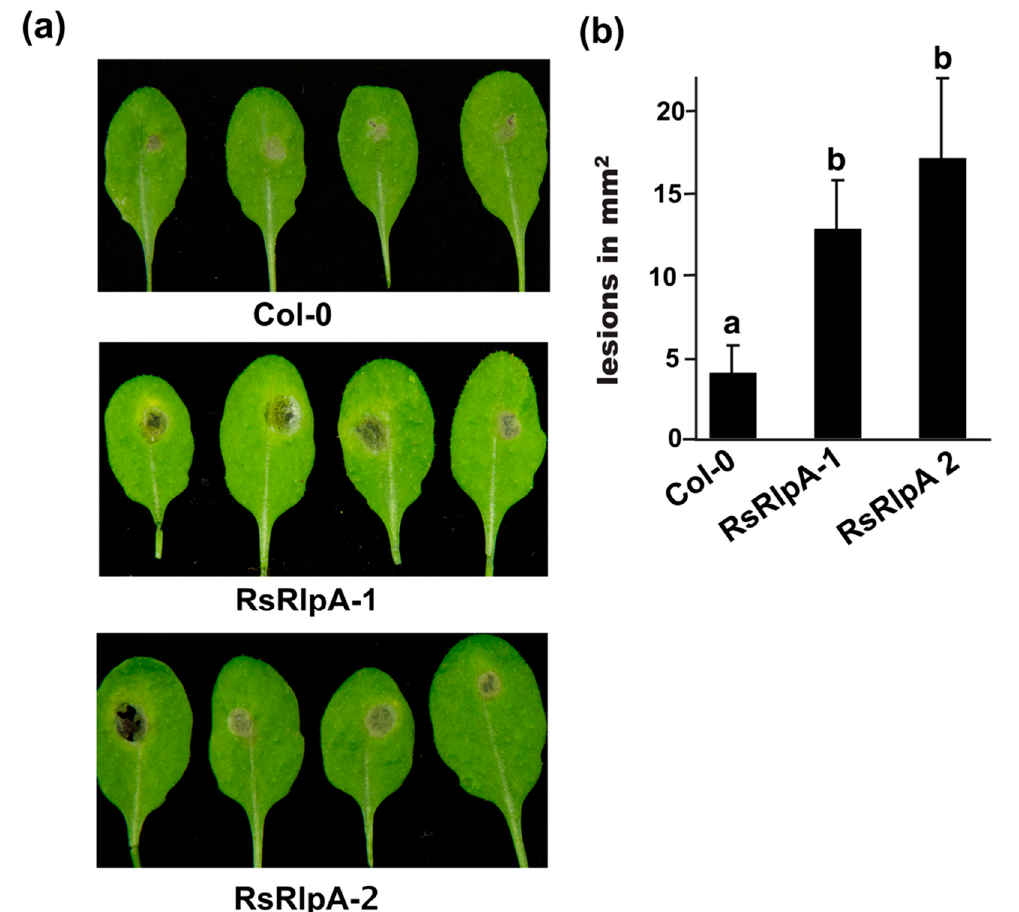
Figure 2. Expression of RsRlpA in Arabidopsis thaliana promotes fungal infection. ( a ) Symptoms of A. thaliana leaves from wild type (Col-0) and overexpression RsRplA lines after infection with Botrytis cinerea conidia. Images taken 3 dpi. ( b ) Lesion area on A. thaliana leaves infected with B. cinerea 3 dpi. Different letters ( a , b ) indicate significant differences according to Tukey’s test ( p < 0.05). Error bars represent SD of four biological replicates, containing four infected leaves from four plants.